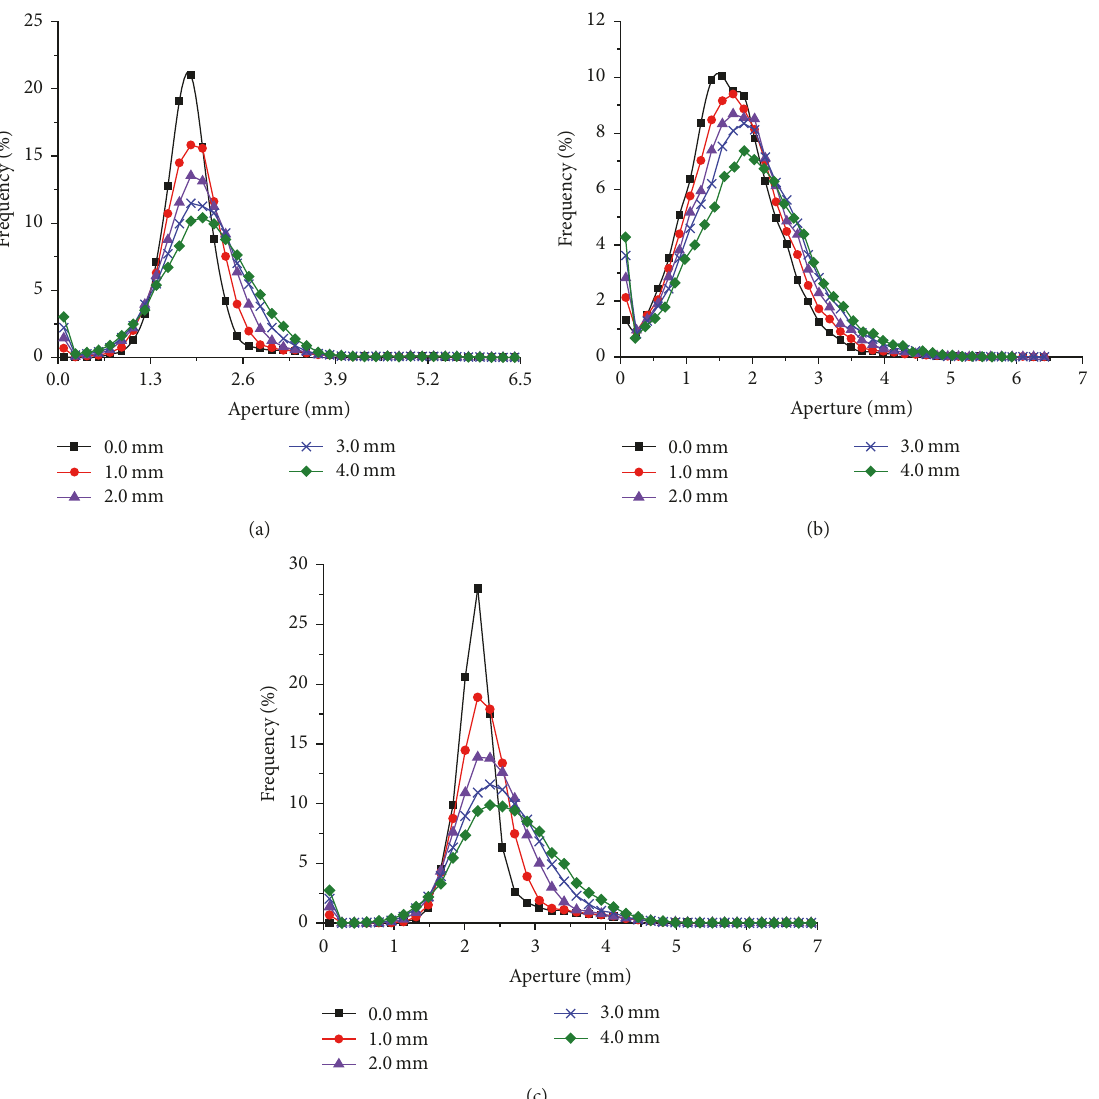
Figure 9: The frequency histograms of the aperture distributions of specimens (a) Gr1, (b) Gr3, and (c) Gr5 during shear.